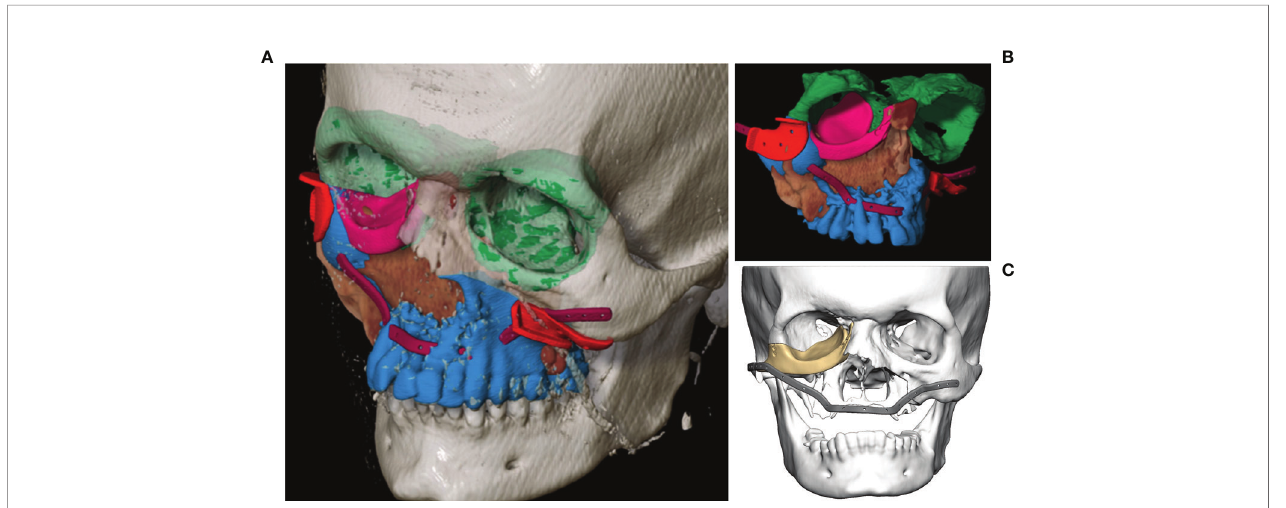
FIGURE 3 | Virtual segmentation and planning of the functional defect reconstruction in a case of Ewing ’ s sarcoma of the midface. (A, B) Segmentation of the tumor extent (brown) and the planned bony resection (blue) with the resection border indicated by the cutting guides (red). The anatomical subunit of the left orbit has been mirrored to reconstruct the right orbit (both green) as a planning template for the right orbital fl oor reconstruction with a patient speci fi c PEEK implant (pink). The outer contour of the maxilla is reconstructed with a patient speci fi c titanium reconstruction plate (purple). (C) Both PSIs are